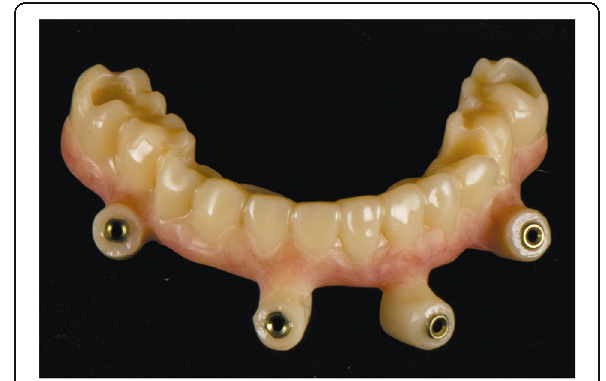
Fig. 6 Computer-aided manufacturing of surgical templates for implant placement